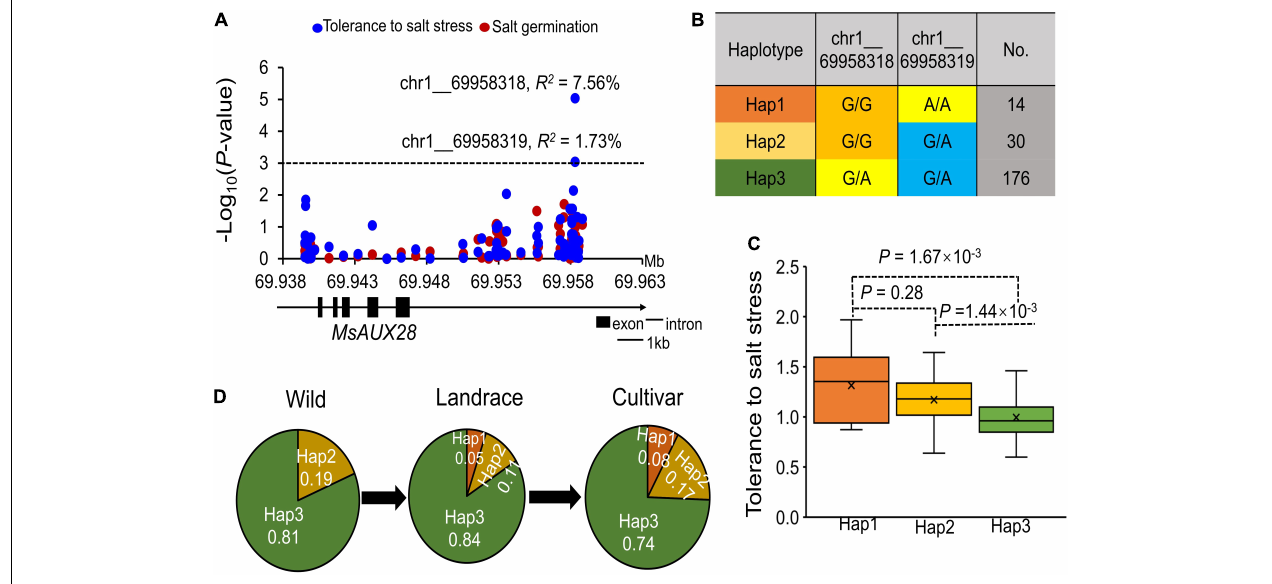
FIGURE 6 | MsAux28 involvement in the salt stress response in alfalfa. (A) Association analysis of the SNPs located within the MsAUX28 gene region and tolerance to salt stress and germination ability under salt stress. R 2 means the phenotypic variation that can be explained by this locus. (B) Haplotype analysis of the two significant SNPs. (C) Comparison of salt stress tolerance the three haplotypes. And, there are three haplotypes (Hap1: G/G:A/A; Hap2: G/G:G/A; Hap3: G/A:G/A). (D) Allele frequency of the three haplotypes in the Wild, Landrace and Cultivar subgroups.